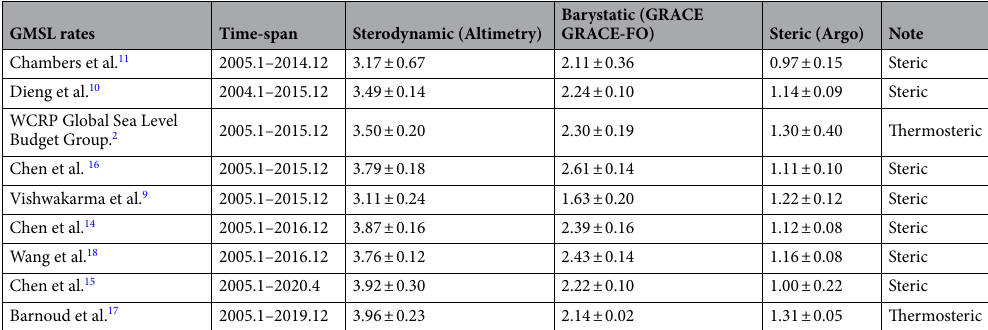
Table 1. Published estimates of global mean sea-level change rates from Altimetry, Argo, GRACE and GRACE-FO solutions [mm/year]. All the statistical results are part results of these above references. Steric includes thermosteric and halosteric contributions and Thermosteric includes only thermosteric